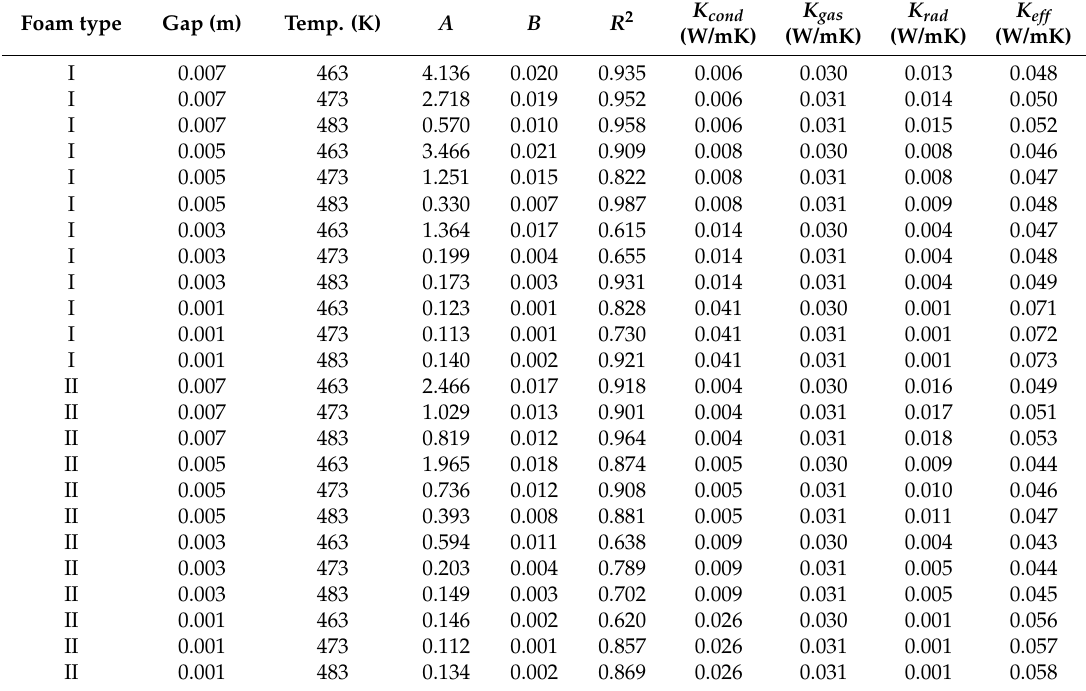
Table 2. Radiative and conductive properties and the two coefficients in the exponential equation. Foam